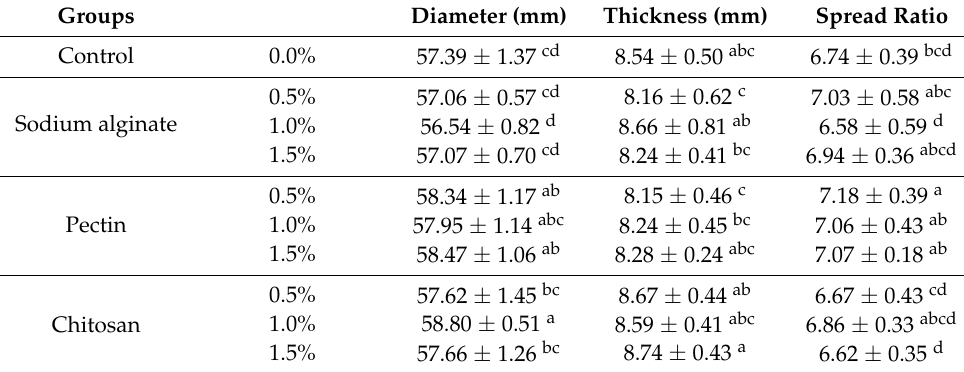
Table 1. Diameter, thickness and spread ratio of biscuits added of sodium alginate, pectin or chitosan in different concentrations. Groups